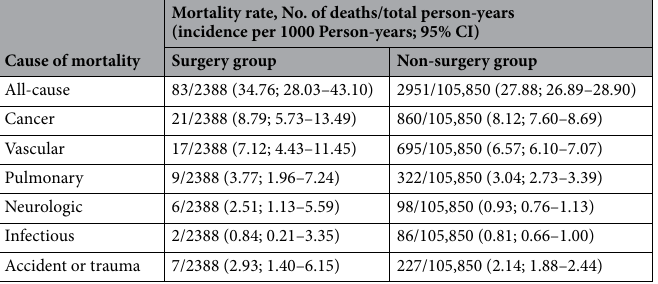
Table 2. Mortality rates of Korean elderly patients according to history of glaucoma surgery. Cox model with glaucoma surgery status as a time-varying covariate. CI confidence interval.